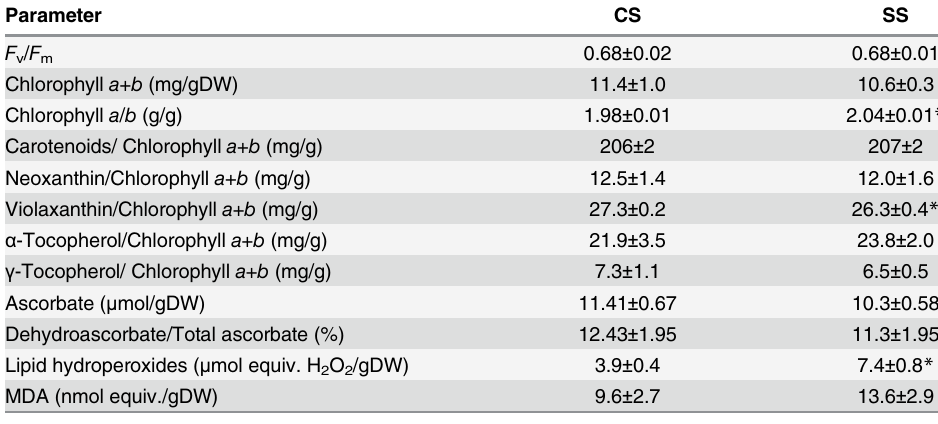
* Signi fi cant differences between treatments (Student's t -test, P < 0.050)